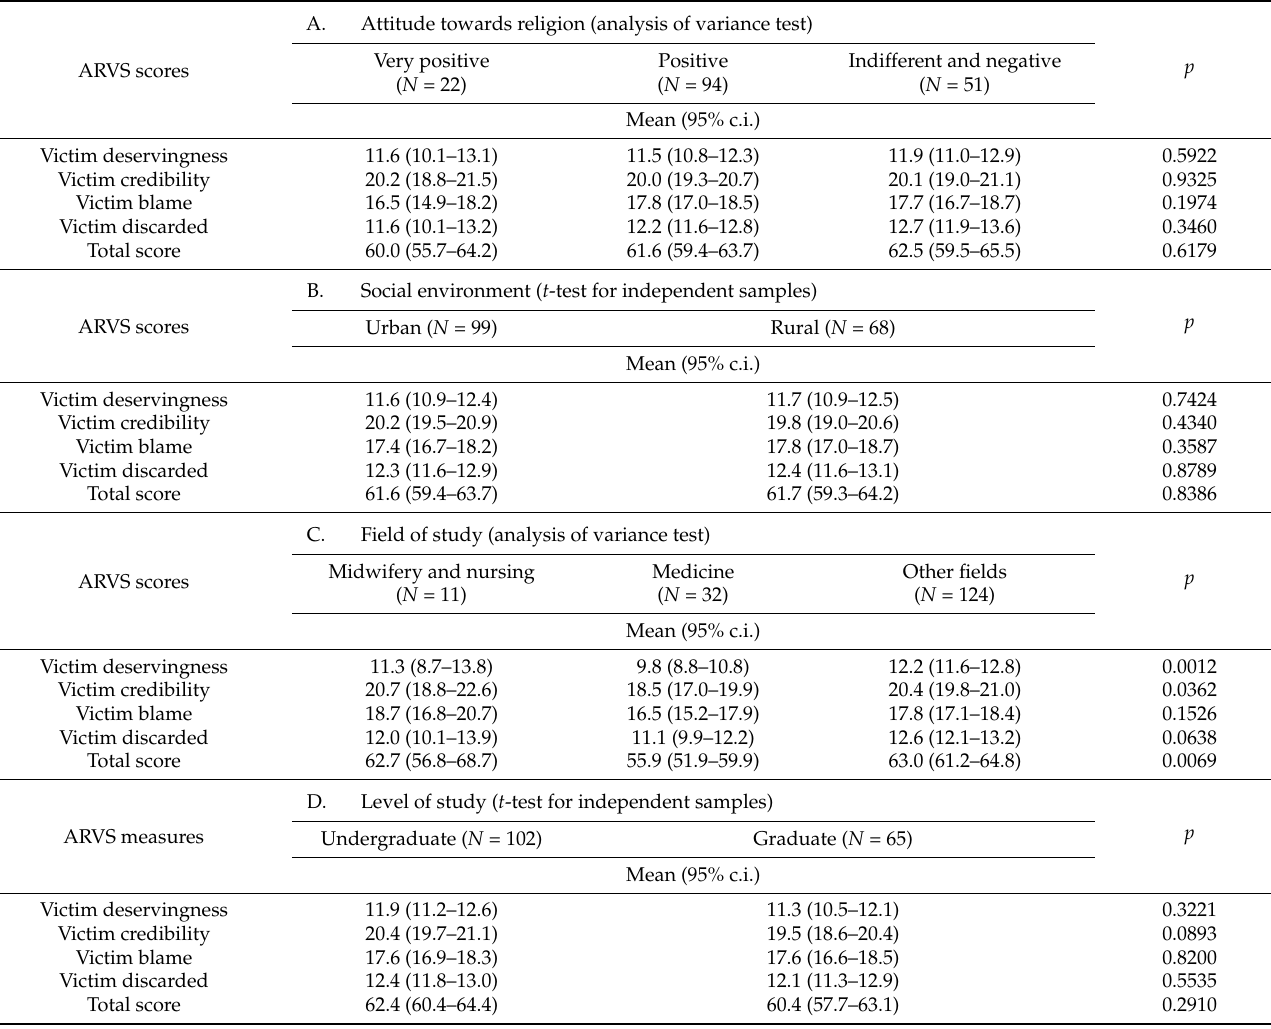
Table 4. ARVS scores among the surveyed